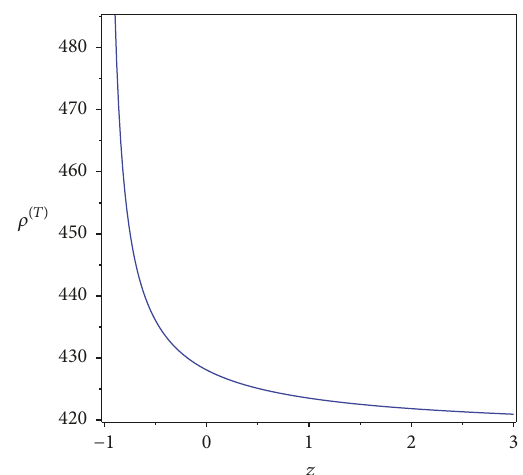
Figure 1: Variationof the effectiveenergy density versusthe redshift for 𝑓(𝑇) = 𝑇 + 𝑓 0 (−𝑇) 𝑝 .